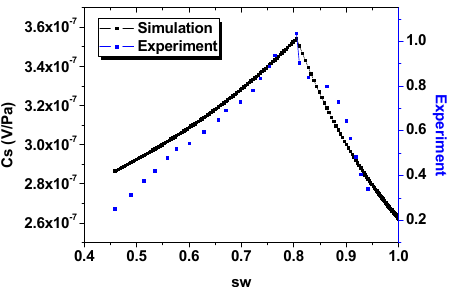
Figure 13. Comparison between simulation and Allègre’s experiment.